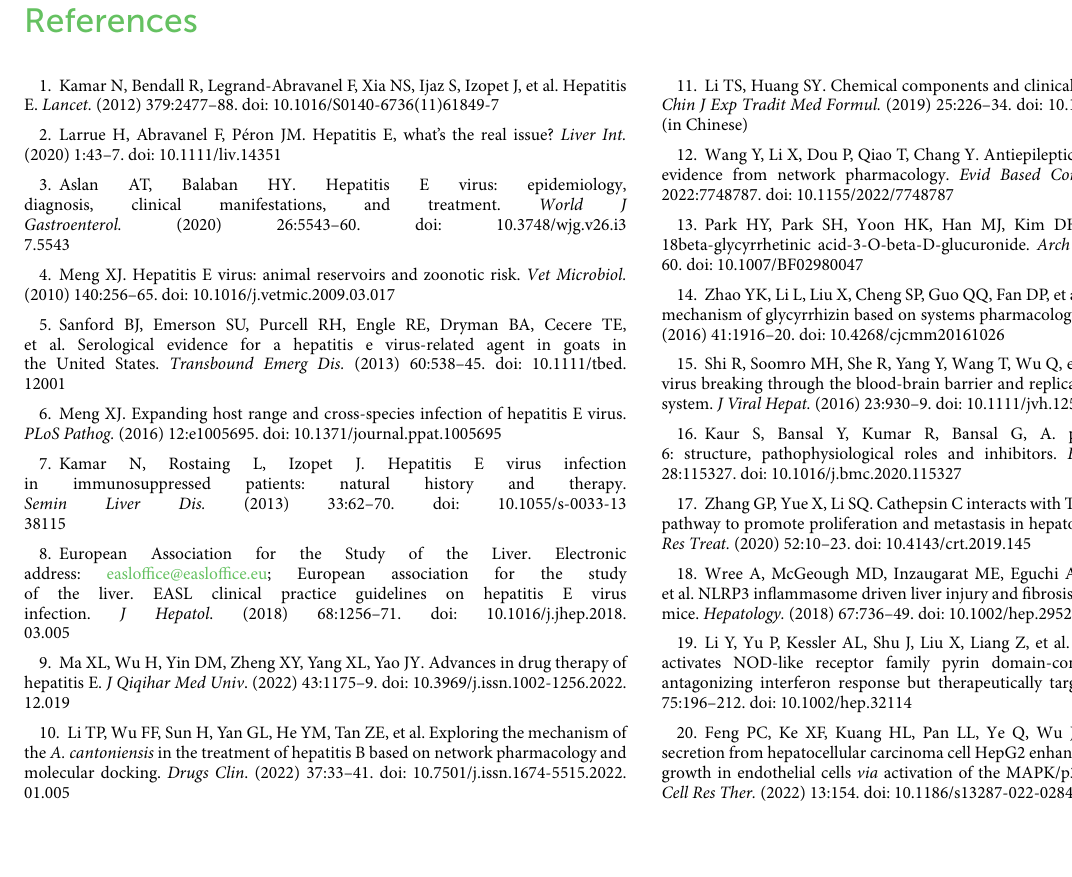
SUPPLEMENTARYTABLES1 Chemical composition of A. cantoniensis Hance. SUPPLEMENTARYFIGURES1 Intersection target of A. cantoniensis Hance and hepatitis E. SUPPLEMENTARYFIGURES2 Map of core